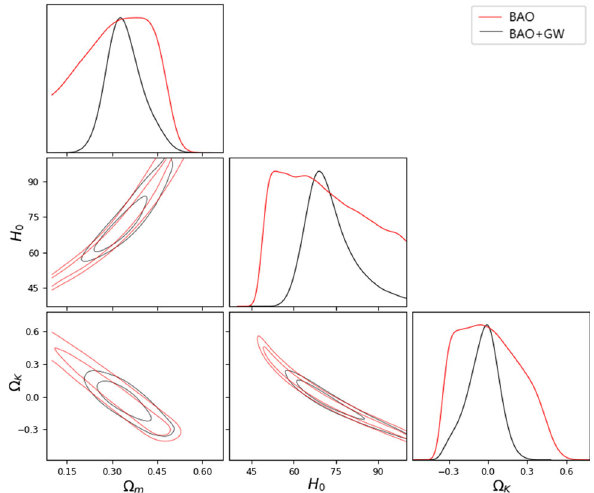
Fig. 2 The 1D PDFs and the 2D contours for the independent param- eters in the Ω k Λ CDM model